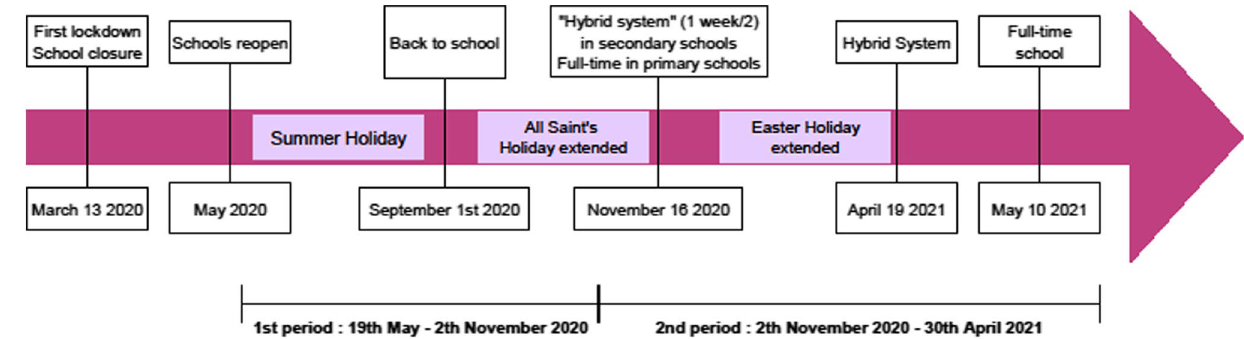
Fig. 1 Chronology of restrictive measures taken to fight the COVID-19 pandemic, from an academic